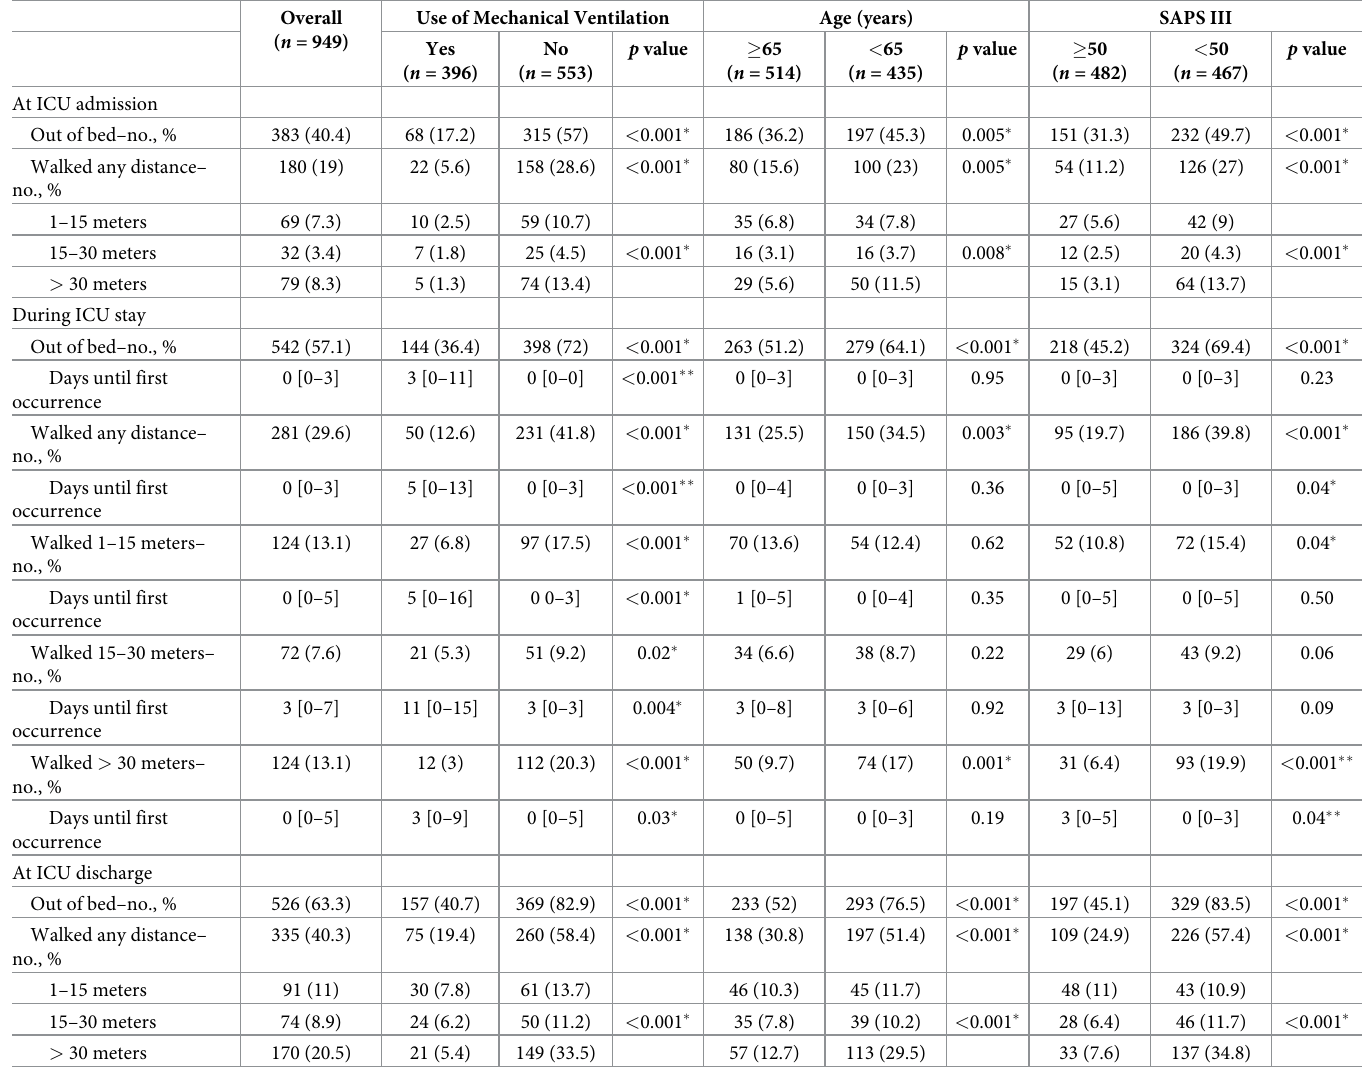
Table 3. Degree of mobilization according to different clinical characteristics at